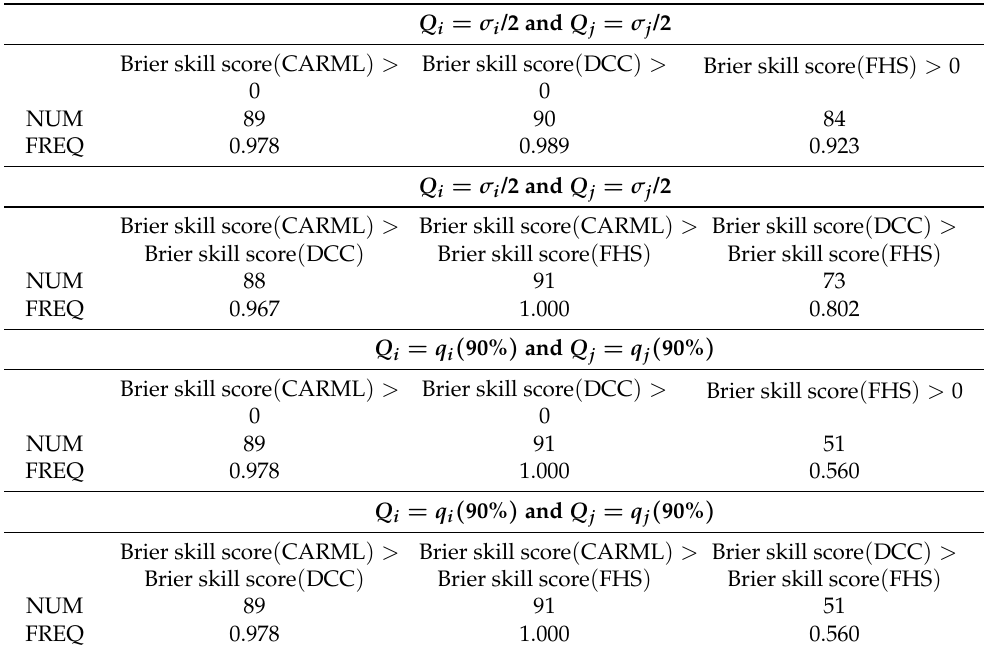
Table 4. Brier skill scores for all the pairs of commodities.